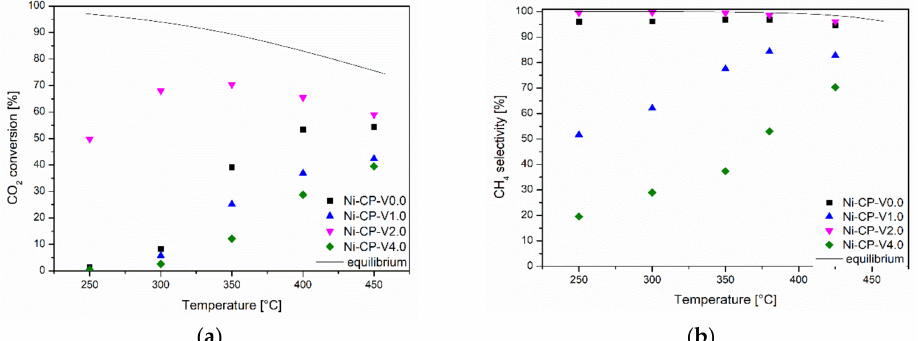
Figure 1. ( a ) CO 2 conversion as a function of temperature; ( b ) CH 4 selectivity as a function of temperature for hydrotalcite-derived